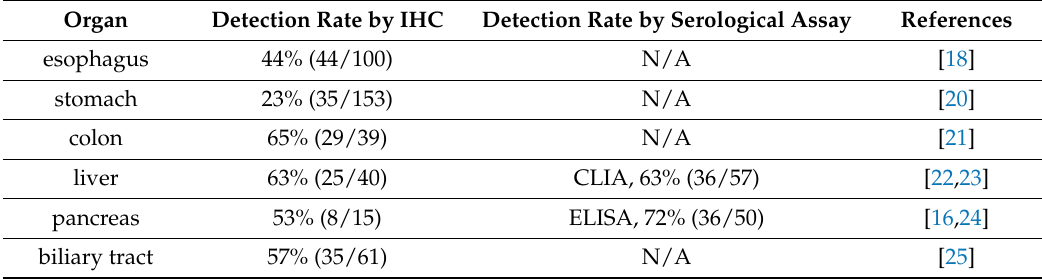
Figure 2. Detection of the γ 2 chain of Ln-332 trimer and monomeric Ln- γ 2 (Ln- γ 2m) chain in gastric carcinoma in vivo. The γ 2 chain of Ln-332 trimer was detected in the basement membranes of carcinoma tissues, whereas monomeric γ 2 chain was selectively detected in the leading edge of carcinomas. Arrowheads, positive signal for the monomeric Ln- γ 2 chain. Magnification: 200 × . Figure 2 is modified from Koshikawa et al. [14]. Table 1. Reported studies of expression of Ln- γ 2 in cancer of gastrointestinal tract.